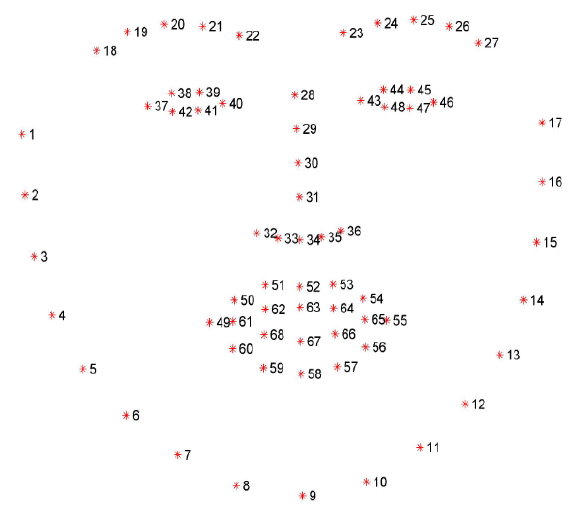
Figure 4. Facial landmarks acquired from Dlib predictor. Each landmark point determine a specific part of the face [29].